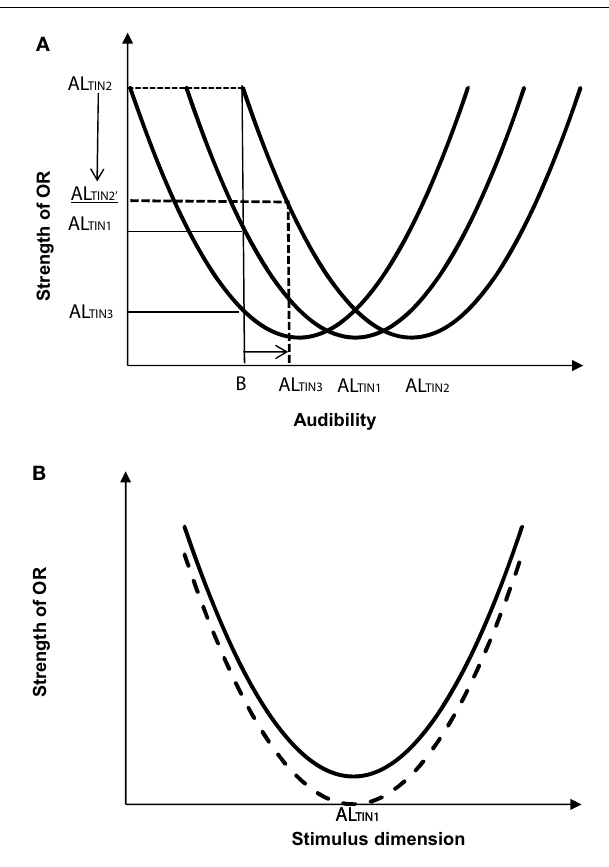
FIGURE 1 | (A) Theoretical relationship between orienting response (OR) to tinnitus in a background sound B as a function of different tinnitus adaptation levels (ALTIN1, ALTIN2, and ALTIN3; B < AL; based on Lauterbach, 1979, Figure 2).The curves represent signal distribution.The OR is greater to the more audible tinnitus (OR ALTIN2). An increase in background sound level (horizontal arrow) should reduce orientation to the tinnitus (illustrated for one adaptation level, OR ALTIN2 reducing to ALTIN2 , the direction of change is shown by the vertical arrow). (B) OR before (top curve) and after (bottom curve) attention training. Less focus on tinnitus should reduce the strength of OR to tinnitus (shown for ALTIN2).